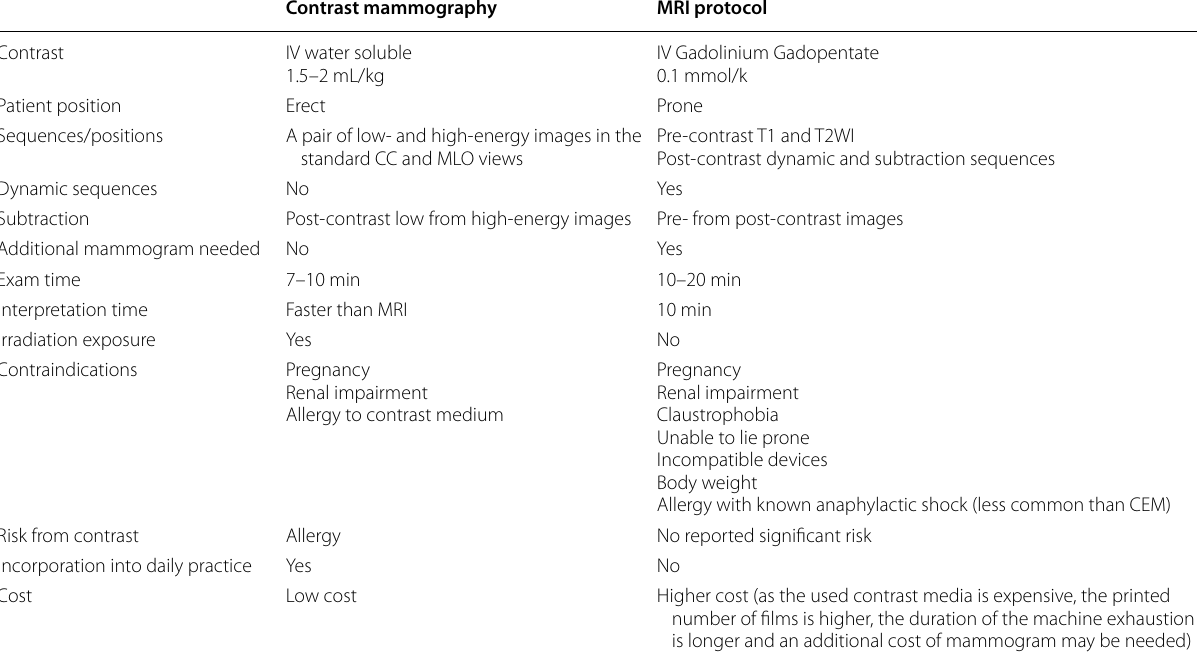
Table 1 Comparison between the strengths and the drawbacks of the contrast-based techniques used for breast imaging Contrast